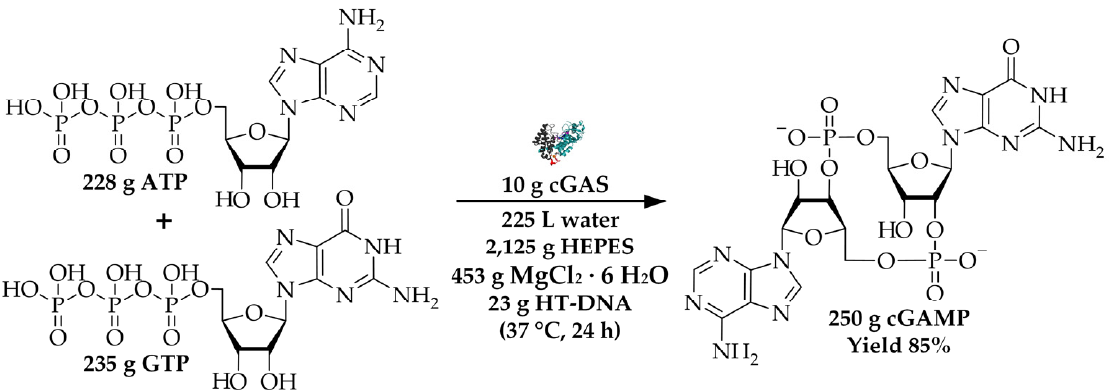
Figure 1. Overview of cGAMP synthesis with 10 g cGAS. The reaction is performed in a reaction volume of 225 L containing 40 mM 4-(2-hydroxyethyl)-1-piperazineethanesulfonic acid (HEPES) buffer, 10 mM MgCl 2 · 6 H 2 O and 23 g herring testes DNA (HT-DNA) for the activation of the